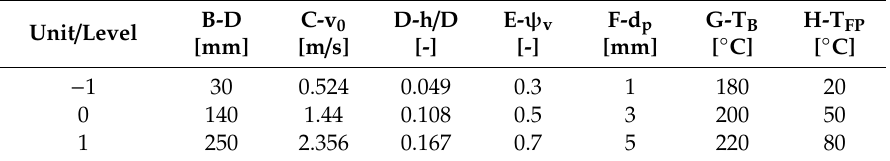
Table A3. Linear coded units of 2-FI regression model.